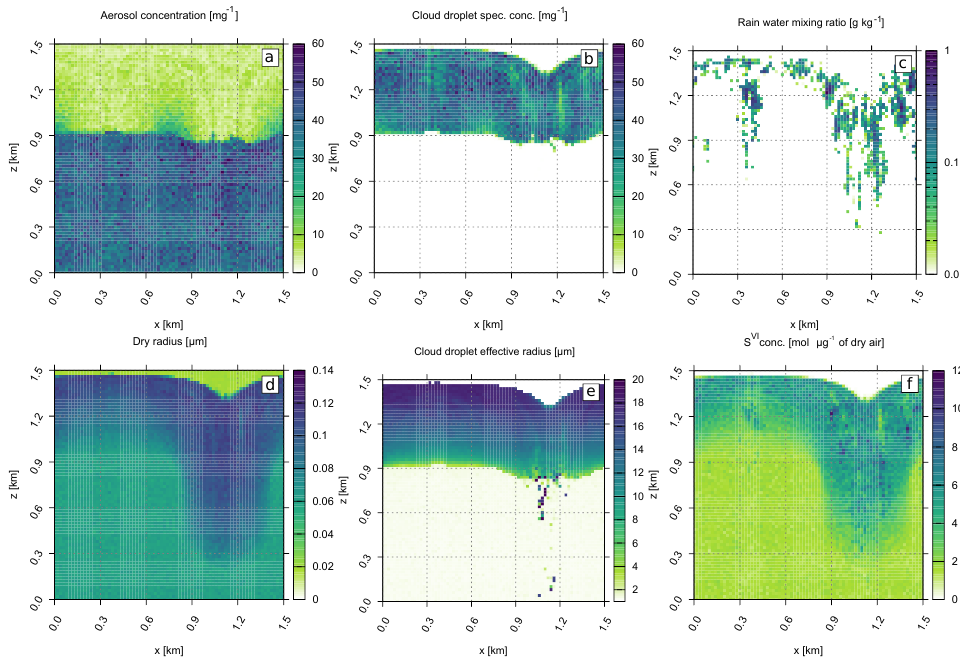
Figure 4. The base case set-up (see Table 2). All panels depict the model state after 30min simulation time (excluding the spin-up) and show unactivated aerosol concentration (a) , cloud droplet specific concentration (b) , rain water mixing ratio (c) , mean dry radius (d) , cloud droplet effective radius (e) , and concentration of S VI molecules (f) . The three thresholds for particle radii are unactivated aerosol < 1µm; 1µm < cloud < 25µm; rain > 25µm. Note the logarithmic scale for the rain water mixing ratio